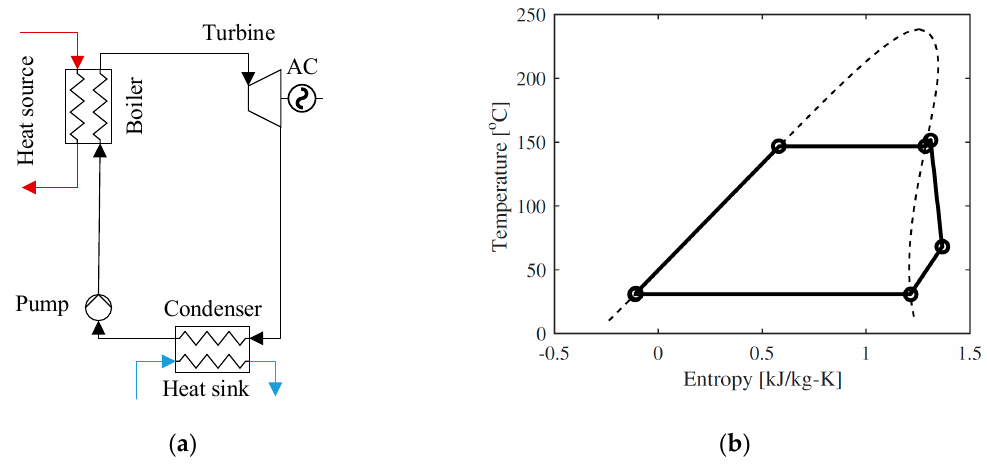
Figure 1. Considered organic Rankine cycle (ORC): ( a ) layout, ( b ) T-s diagram.